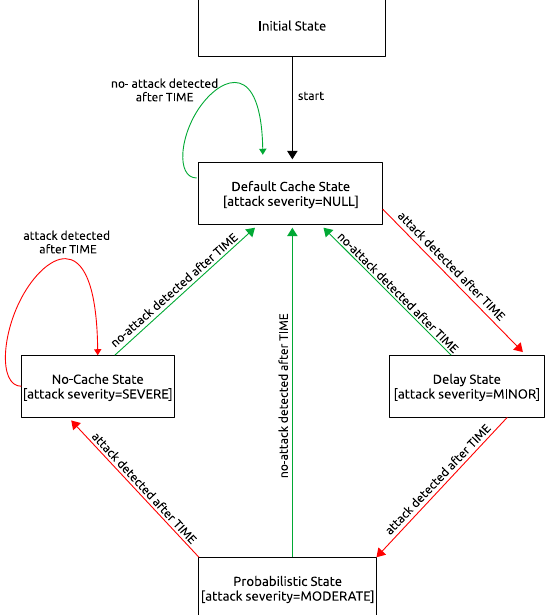
Figure 10. DaD attack states and countermeasures for the attack